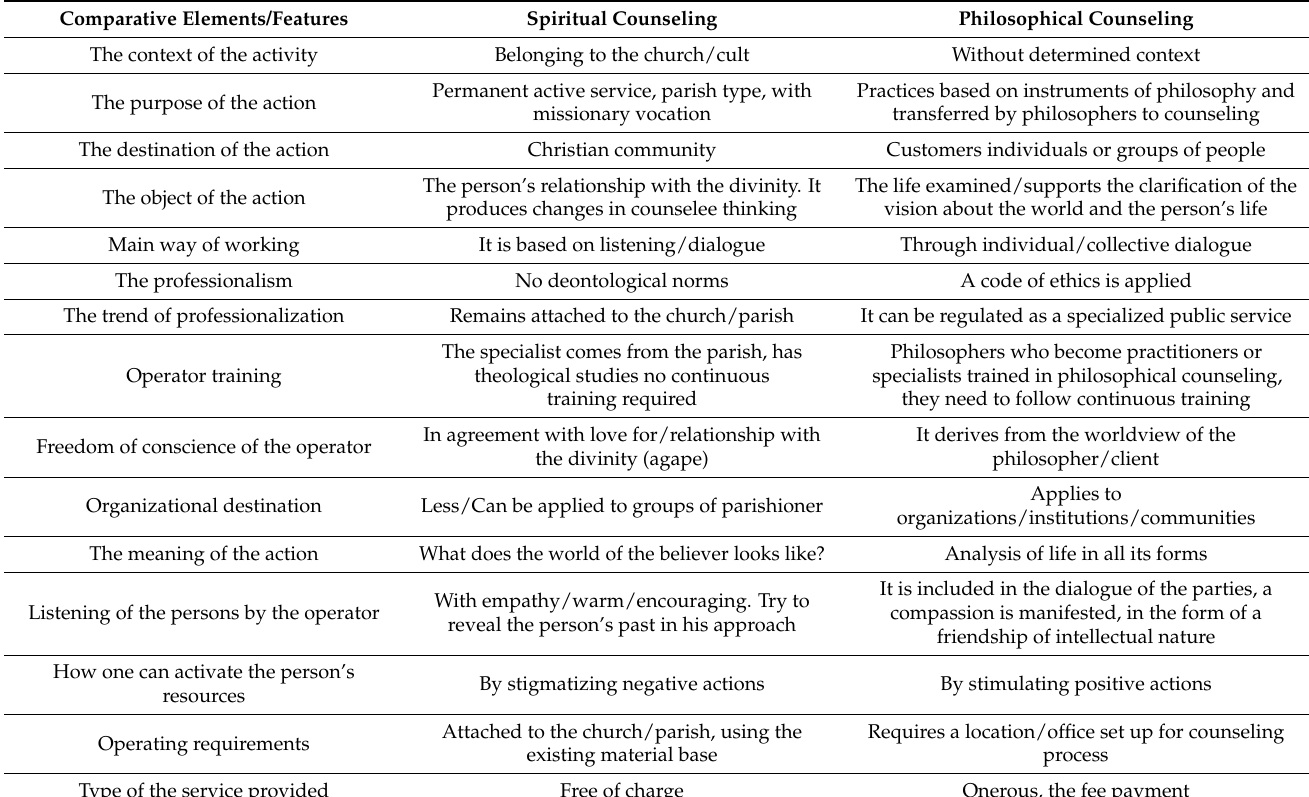
Table 1. Comparative elements of the spiritual and philosophical